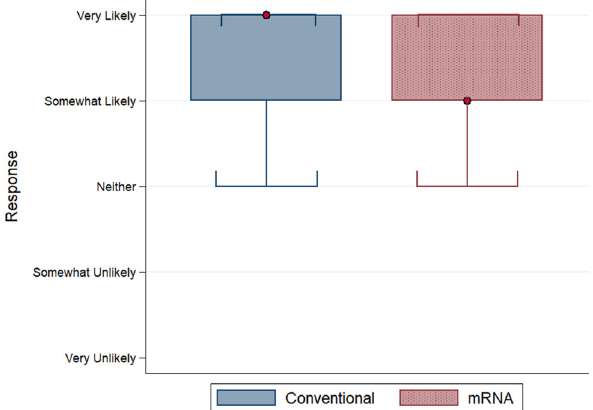
Fig. 1 The distribution (box and whisker plots) of responses, by vaccine type, to the question “ Suppose the [conventional/RNA] Covid-19 vaccine is endorsed by your Government, free, [but no one/and 20%/ and 40%/and 60%/and 80% of people] in your country [has/have] received the vaccine. How likely are you to accept the vaccination? ” Boxes indicatemedianandinterquartilerange(IQR) withthereddotspecifying median value, and whiskers indicate range (data within 1.5*IQR). Conventional vaccine n = 17,527 responses; mRNA vaccine n = 17,646 responses. The source dataset for the fi gure can be found in Supplementary Data